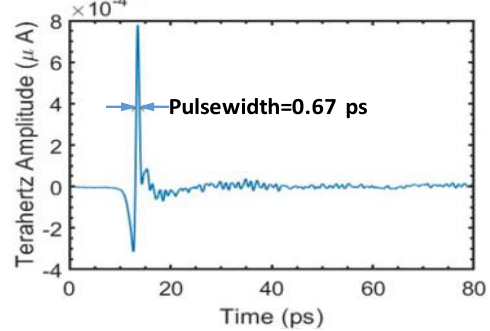
Figure 5. Waveform of a commercial InGaAs-based switch device under 1550 nm pump.